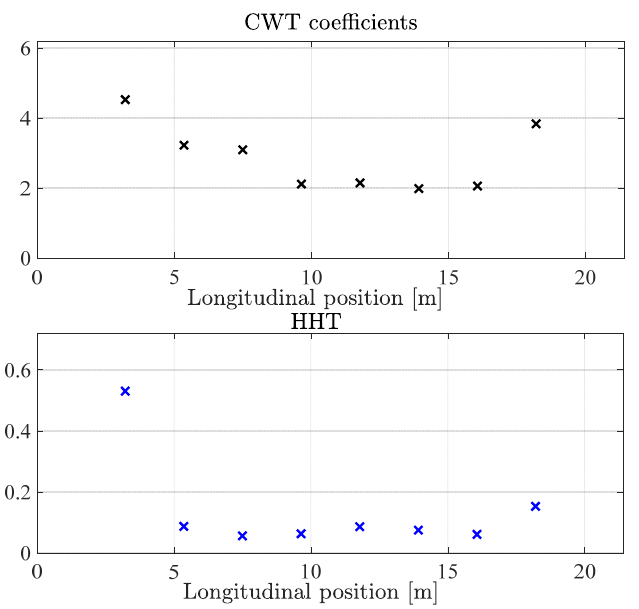
Figure 15. Index magnitudes as a function of damage position across the bridge span, with the CSA travelling at 100 km/h and without track irregularity.